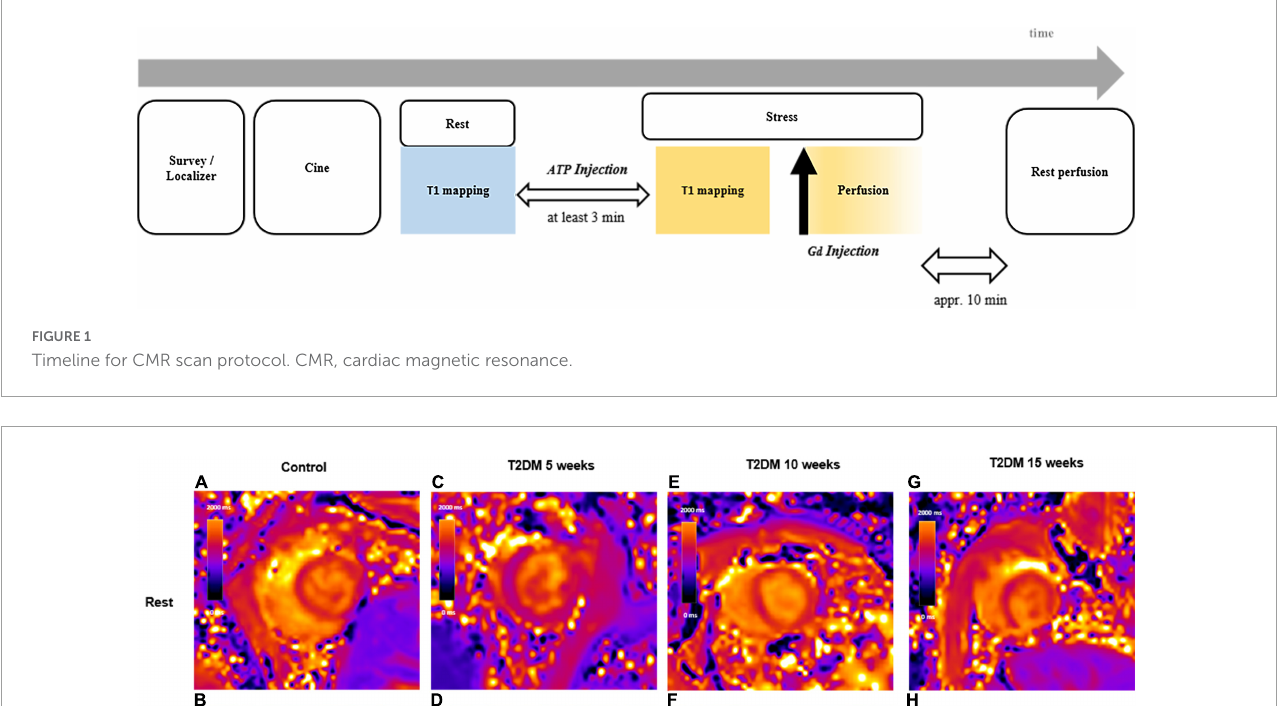
phases in at least one segment or more on stress perfusion